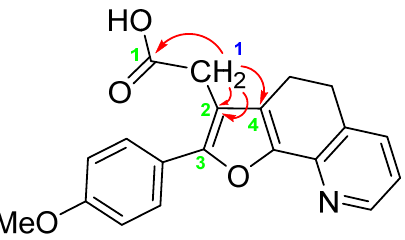
Figure 2. The key HMBC correlations in compound 1. In summary, a simple and efficient multicomponent protocol for the preparation of novel 2-(2-(4-methoxyphenyl)furo[3,2- h ]quinolin-3-yl)acetic acid on the basis of the interaction of 8-hydroxyquinoline, 4-methoxyphenylglyoxal, and Meldrum’s acid was suggested. The use of readily accessible starting materials, along with atom economy and a convenient work-up process, allows one to apply the presented method for the synthesis of a wide range of similar furo[3,2- h ]quinolinacetic acids. The structure of the obtained product was established by 1 H (Figure S1), 13 C (Figure S2), 2D-NMR (Figures S5–S7), IR spectroscopy (Figure S4), and high-resolution mass spectrometry (Figure